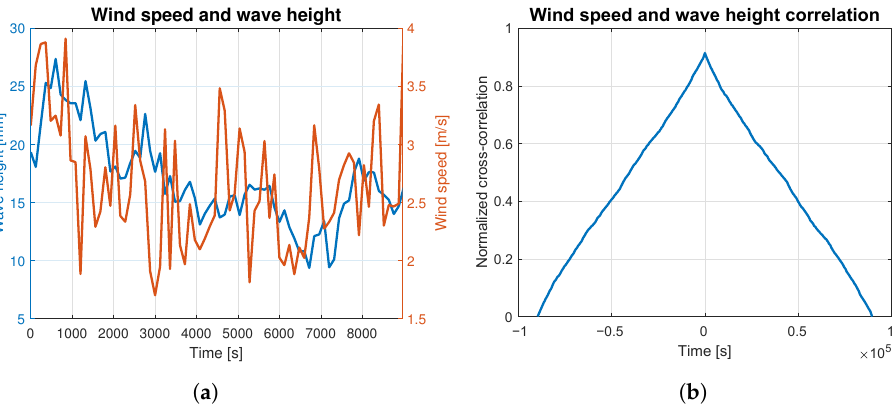
Figure 7. Wind speed and wave height correlation for 7 BFT: ( a ) wind speed and wave height measurements; ( b ) wind speed and wave height